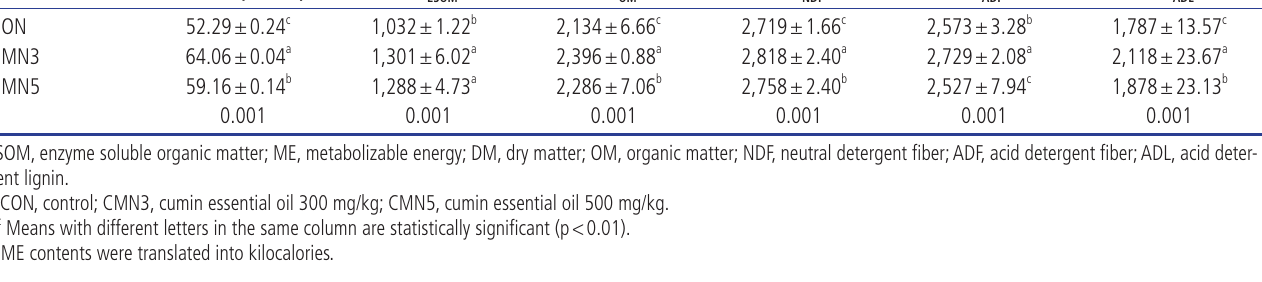
Table 6. ESOM and ME contents of alfalfa silages (kcal/kg DM) Treatments